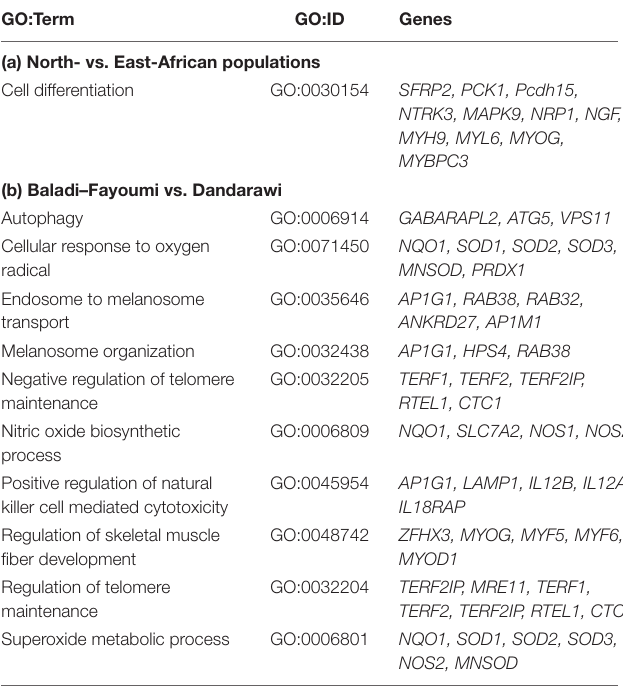
TABLE 2 | A subset 1 of gene ontology (GO) enrichment and annotated genes within sweeps of inter-population F ST ; (a) North- vs. East-African populations 2 and (b) Baladi–Fayoumi vs.